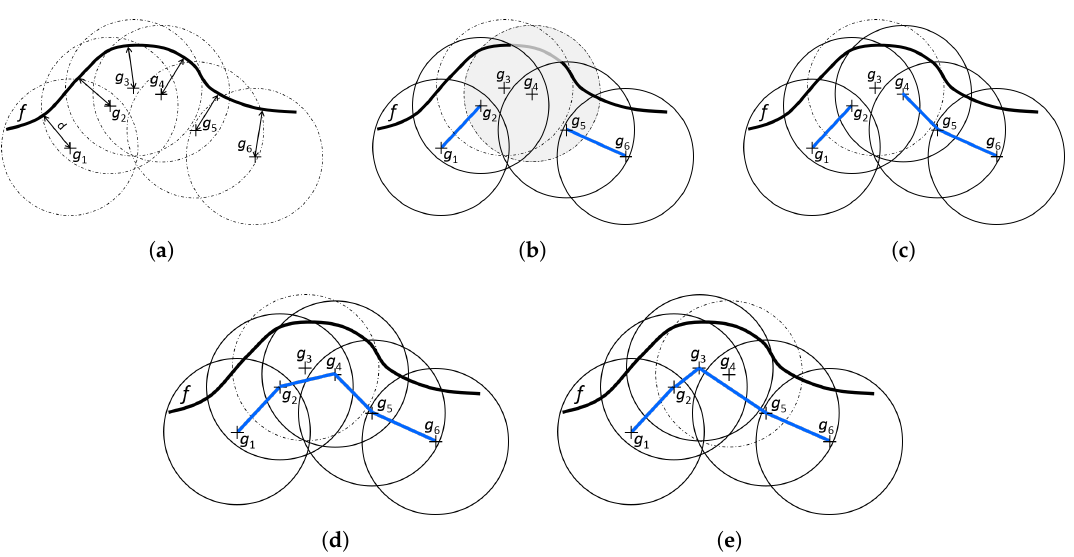
Figure 8. An example with a single frontier, six candidate goals equally distant from the frontier and the priority list P = [ g 1 , g 6 , g 4 , g 2 , g 3 , g 5 ] . ( a ) the scenario; ( b , c ) partial coverages of frontier f after